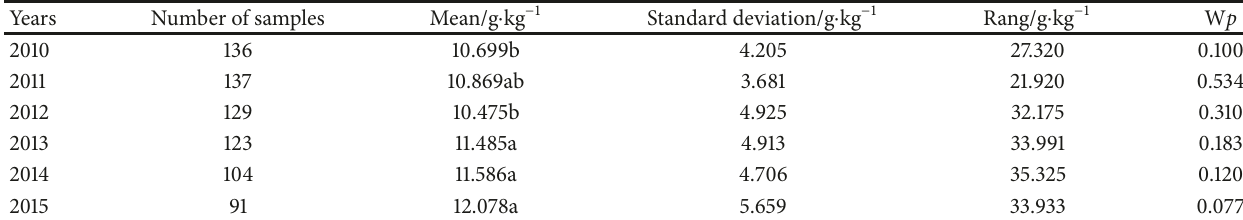
Table 1: Characteristic statistical values of SOC for different